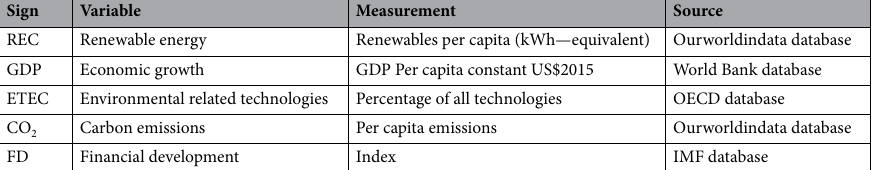
Table 1. Variables and